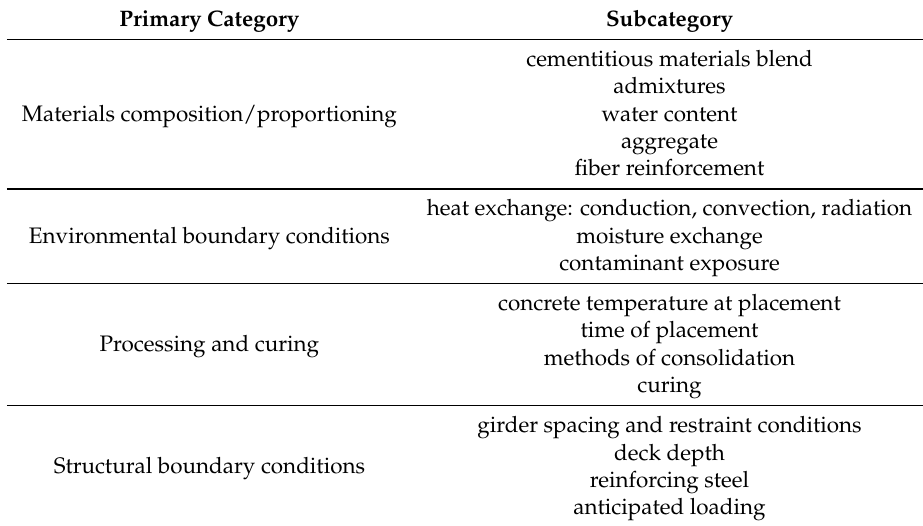
Table 1. Design parameters affecting early-age cracking of bridge